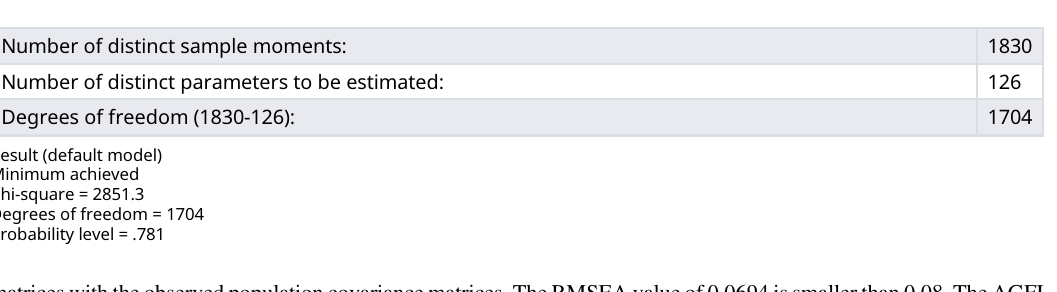
Table 4. Estimasi parameter covarian data and the